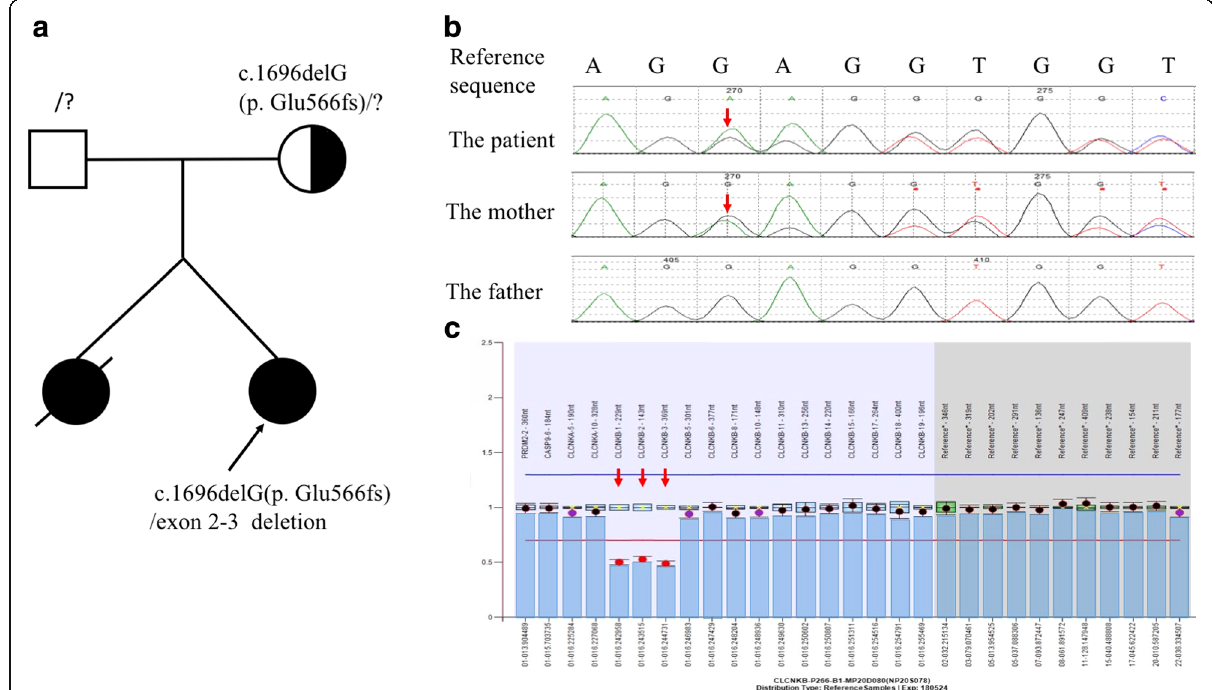
Fig. 1 Mutation analysis by direct sequencing in CLCNKB . a pedigree of the patient ’ s family. The arrow indicates the proband; her elder identical twin sister was clinically hypothesized died of BS. b Mutation analysis by direct generation sequencing in CLCNKB . The patient is compound heterozygous, the point deletion of c.1696delG (p. Glu566fs) inherited from her mother. c MLPA showed the other heterozygous mutation of the deletion of exon 2 – 3 in the CLCNKB of the patient. (Arrow shows the position of the